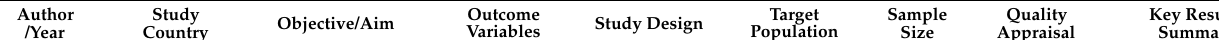
Table 1. Data extraction and quality